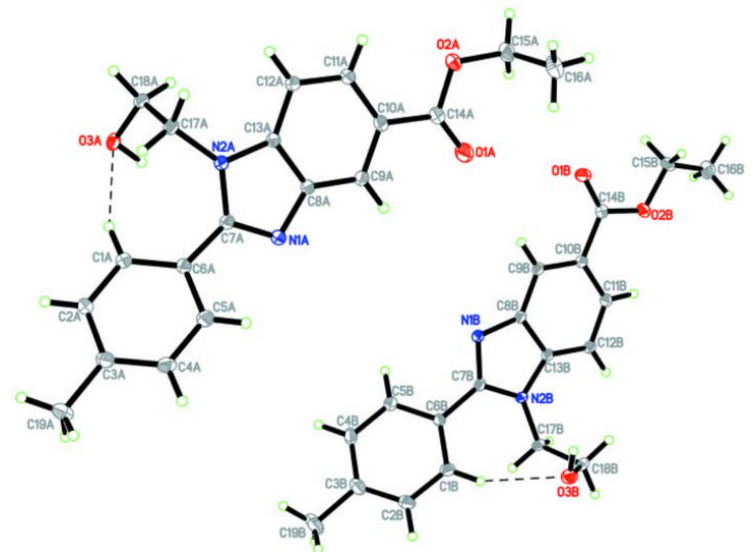
Figure 2. ORTEP digram of 6c (CCDC